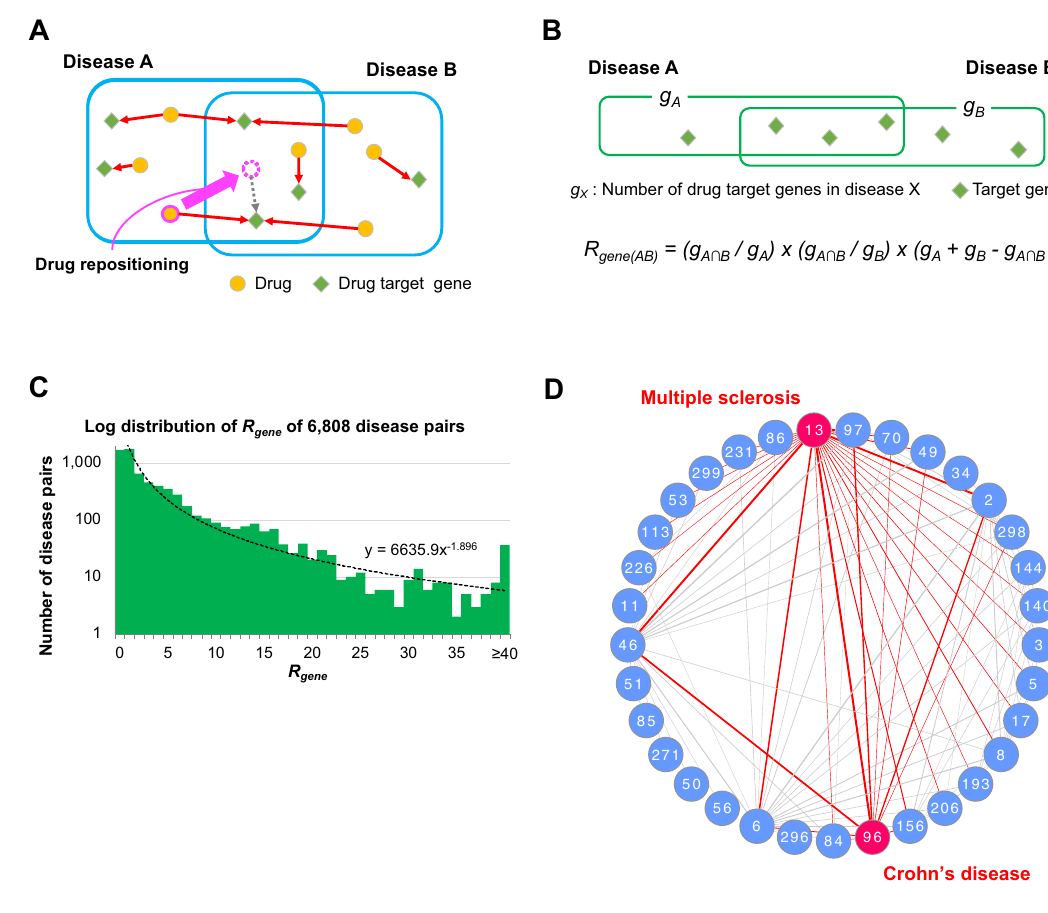
Figure 2. R gene : A score of drug repositionability based on sharedness of drug target genes between a disease pair. ( A ) Schema of drug repositioning where a drug in disease A is repositioned to disease B, with information of drug target genes. Drugs and their target genes are differently positioned across the three regions (disease A only, disease B only, and disease A and B). ( B ) Calculation of R gene as a score of drug target gene sharedness between disease A and disease B. ( C ) Log distribution of R gene of 6808 disease pairs. R gene of 2466 disease pairs (36.2%) was less than 1. Note: disease pairs which had no repositioned drugs are included. ( D ) Inter-disease network by R gene . A circular network consists of 33 diseases from the top 100 R gene disease pairs were depicted. The number of disease pairs (connected lines) are different among the diseases. Multiple sclerosis (ID:13) and Crohn’s disease (ID:96) are paired to many other